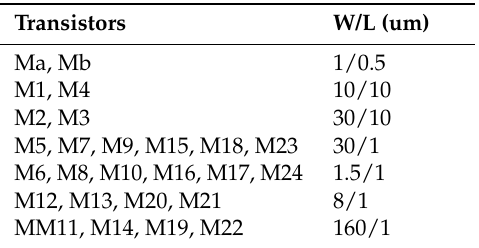
Table 1. Transistor